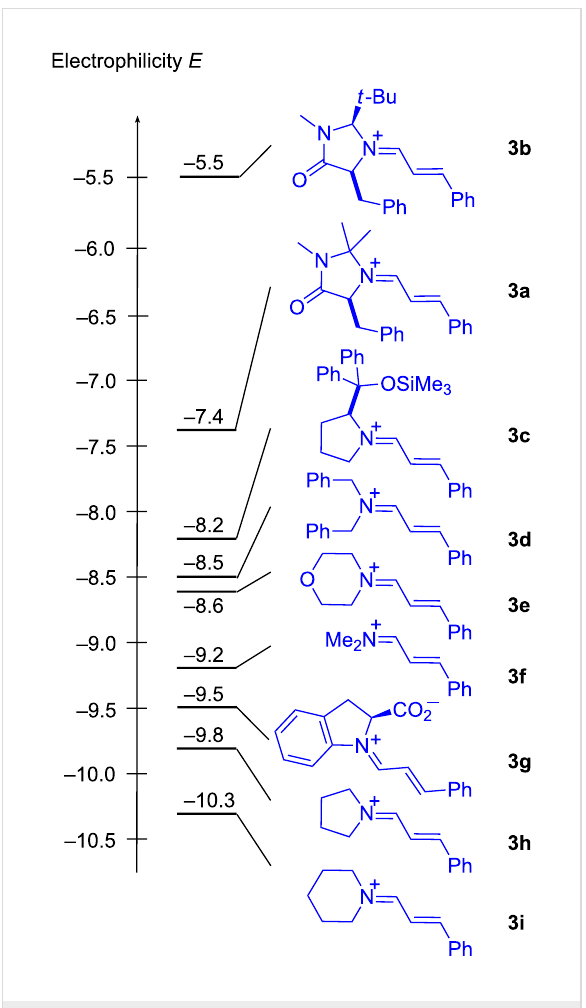
Figure 6: Comparison of the electrophilicities of cinnamaldehyde- derived iminium ions 3a – 3i .